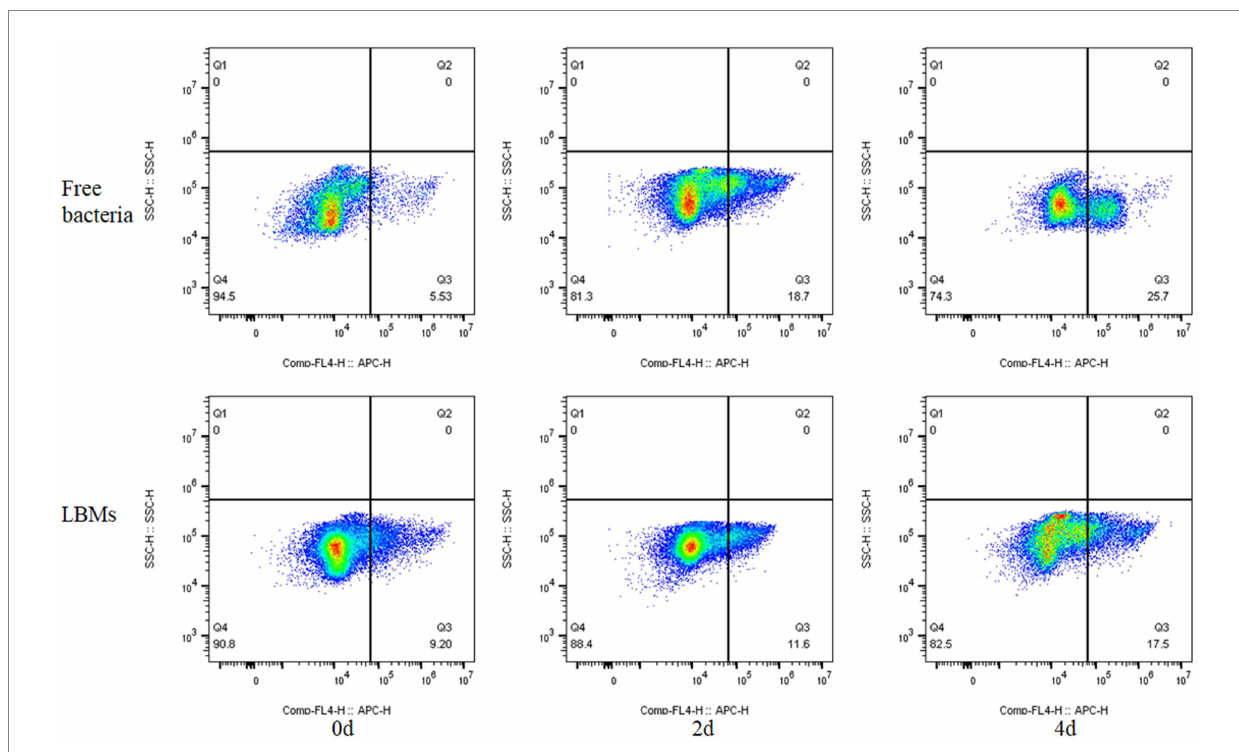
FIGURE 8 Bacteria viability quantified using flow cytometry in free bacteria and LBMs systems (The initial toluene concentration was 500 mg L − 1 ).